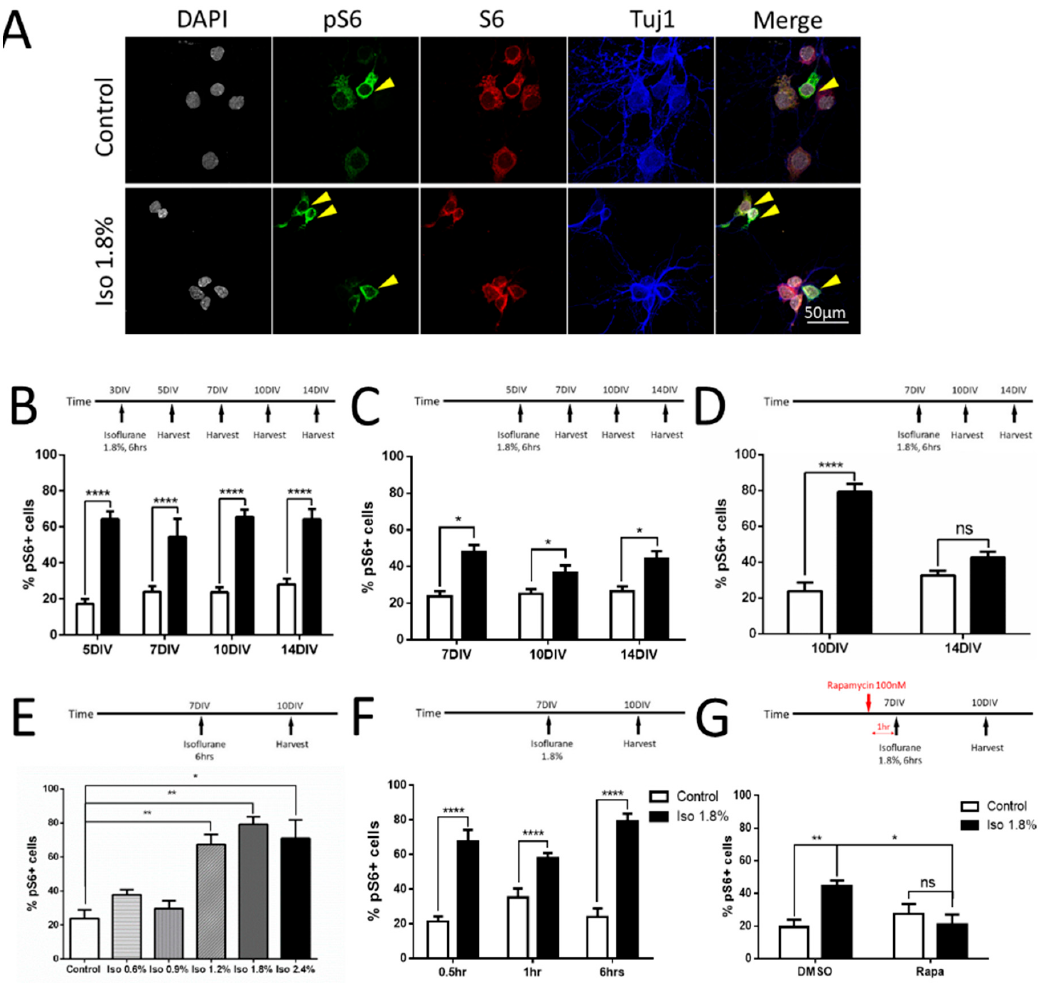
Figure 4. Isoflurane exposure at different time points showed effects on the downstream marker of mTOR pathway. ( A ) Representative images of DAPI (grey), pS6 (green), S6 (red), β III Tubulin (blue) immunofluorescence in the dissociated neurons at 10 DIV. ( B – G ) 6 h of 1.8% isoflurane treatment on different early time points caused significant increases in the percentage of pS6 positive cells among all the DAPI/Tubulin neurons compared to the control group at late time points except the ones exposed on 7 DIV and tested on 14 DIV ( B – D ). The effect on pS6 levels at 10 DIV varied depending on the doses of isoflurane. There was a significant increase in immunoactivity starting from the 1.2% isoflurane group to the 2.4% isoflurane group, while lower doses (0.6% and 0.9%) remained at control levels of pS6 immunoactivity ( E ). Different exposure durations (0.5 h, 1 h and 6 h) of 1.8% isoflurane also resulted in increased pS6 immunoactivity at all exposure times compared to control ( F ). Adding rapamycin, an mTOR pathway inhibitor, reversed the increase of pS6 after isoflurane exposure on 7 DIV ( G ). ( n = 15 fields that were measured per group, * p < 0.05, ** p < 0.01, **** p < 0.0001, n.s. indicates no significant difference, t -test for ( B – F ). one-way ANOVA with Dunnett’s multiple comparisons test for ( E ), two-way ANOVA with Bonferroni’s multiple comparisons test for ( G ).